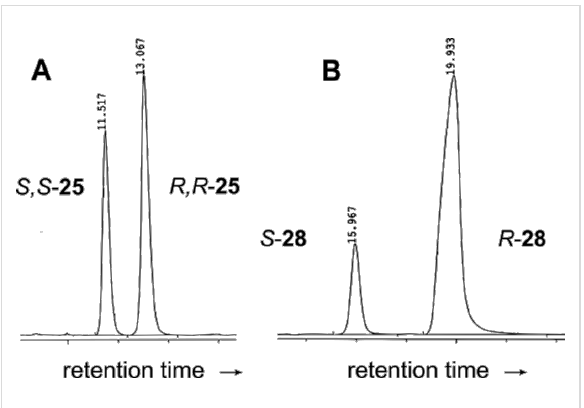
Figure 3: A) Chromatogram of rac- 25 after incubation with 0.1 equiv of 10 in THF at − 15 °C for 64 h. The faster running isomer shows in- creased conversion into 28 . B) The slower running isomer ( R ) of 28 is formed preferentially. The faster running isomer of 25 , therefore, must be S,S